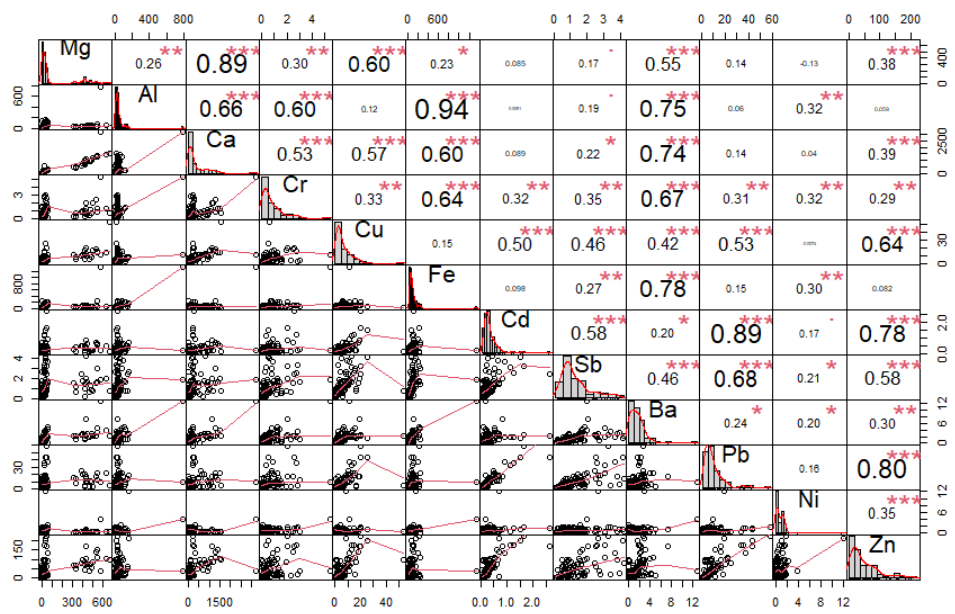
Figure 4. Correlation matrix of elements found in the PM 1 fraction from measurements taken in the city of Žilina ( p -values (0, 0.001, 0.01, 0.05, 0.1, 1) <=> symbols (“***”, “**”, “*”, “.”, “ “)).